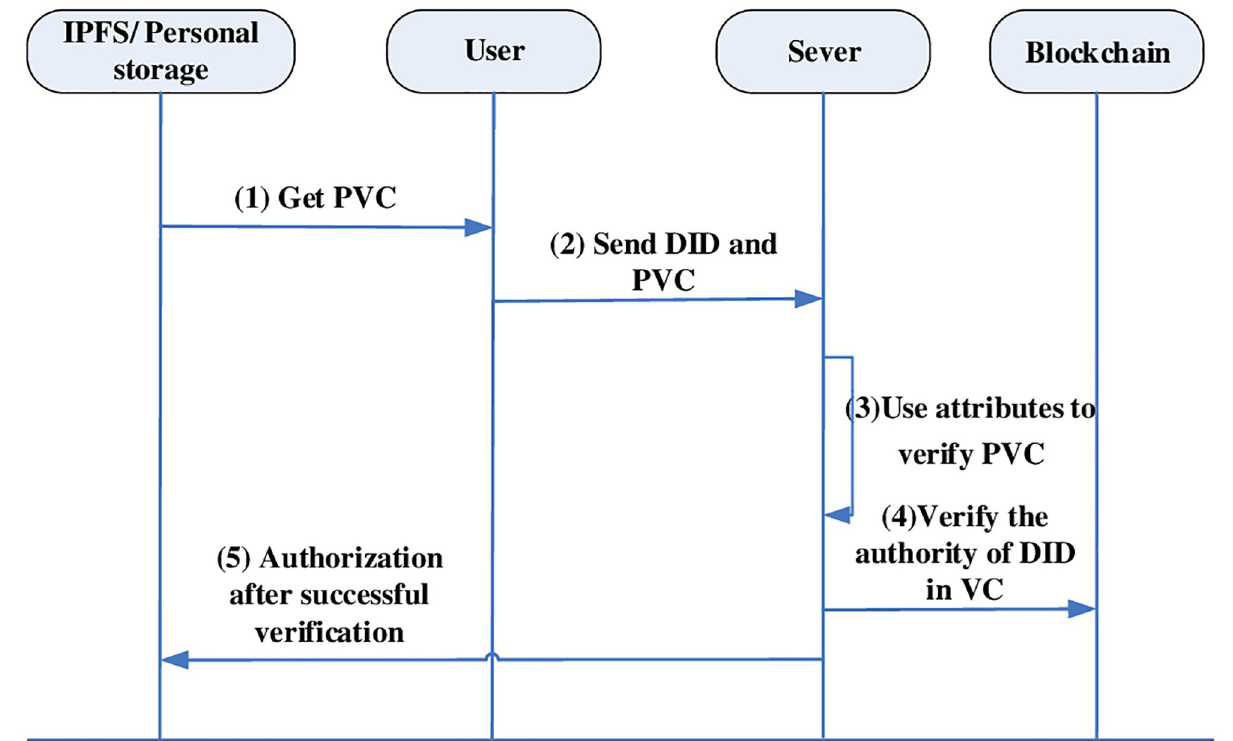
Fig 9. Central domain authentication process.